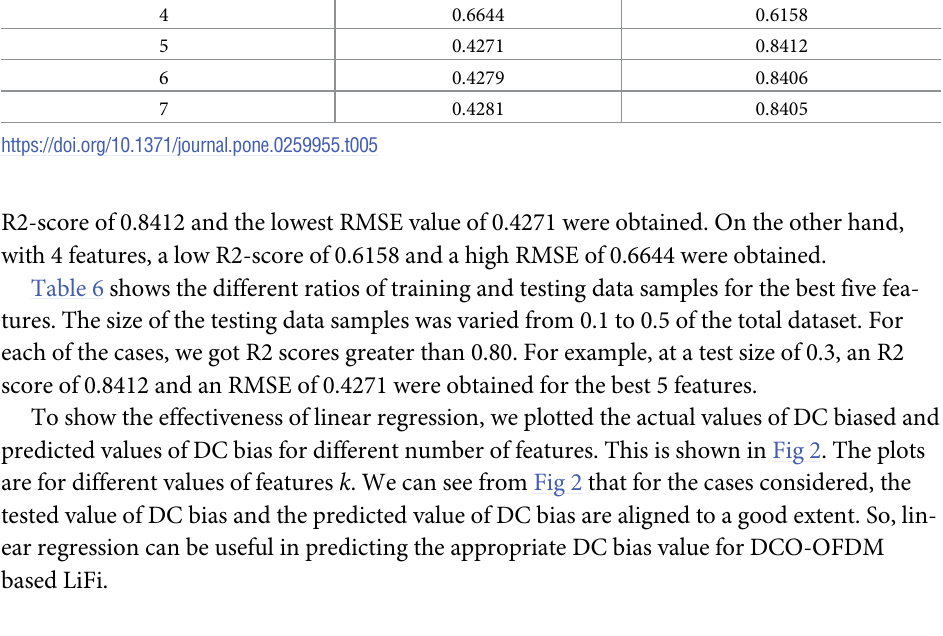
Table 5. RMSE and R2-score in linear regression.